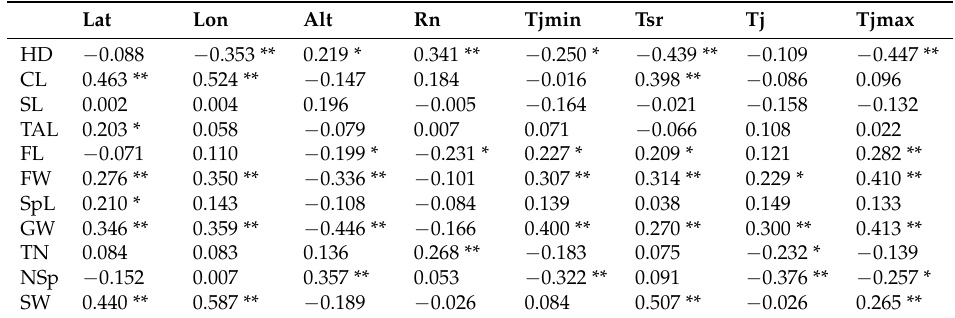
Table 2. Coefficients of correlation (r) between morphological traits of T. dicocciodes and the ecogeographical variables at their sites of collection. Lat Lon